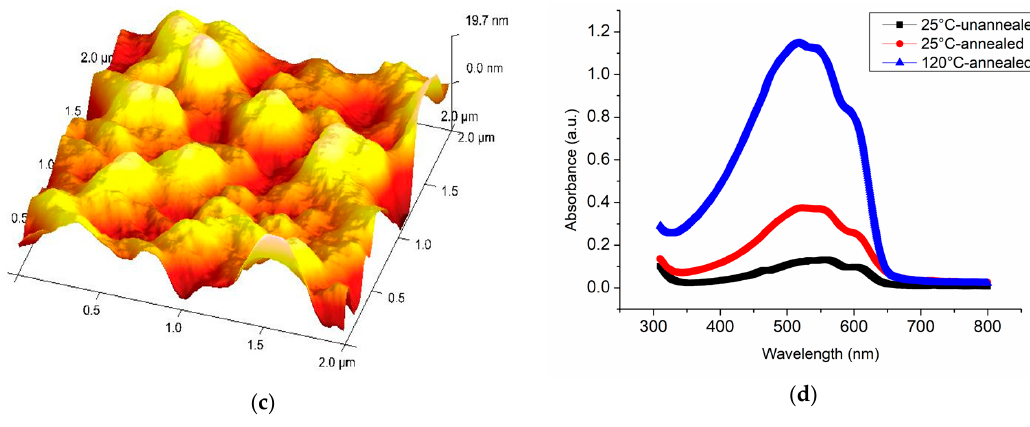
Figure 8. Characterization of nanostructure of RR-P3HT patterns. Atomic force microscope (AFM) images of the obtained RR-P3HT patterns: ( a ) nanofibrils observed on the stripes obtained by evaporative self-assembly at 120 °C and thermal annealing at 140 °C under nitrogen atmosphere; ( b ) nanochains observed in between two stripes of ( a ); ( c ) random distributed microstructure obtained at ambient condition at 25 °C without thermal annealing. ( d ) Absorbance spectra of the RR-P3HT patterns before and after thermal annealing, depicting the blue shift with thermal annealing.